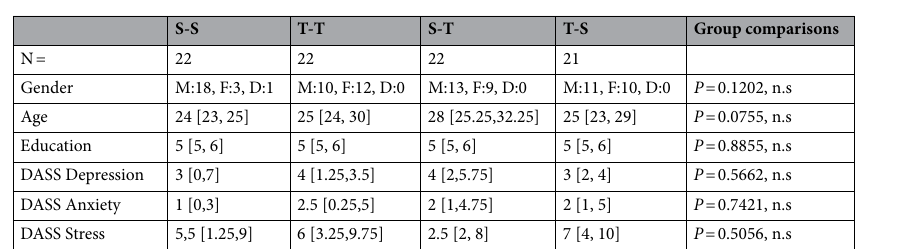
Figure 1. General experimental design and procedures. After the announcement of the presence or absence of distressing screams, the passive walkthrough 1 begun. The tracking shot started in the hallway and entered the rooms in ascending order (1–4). In each room the camera positioned itself at three locations in ascending order (marked by the circled numbers 1–3). Before the camera entered a new room, it returned to the starting point in the hallway. The red dot indicates the position of the person stimuli in the room. The person stimuli were either standing between the couch and the dresser or sitting on the couch. Apart from the person stimuli, all rooms were arranged identically. The rightmost picture depicts an exemplary room. After walkthrough 1 the participants were asked to rate their anxiety, stress and emotional arousal on a 9-point Likert scale and to estimate the length of the walkthrough. This process was repeated for walkthrough 2, which was similar to walkthrough 1, but differed in terms of the position of the person stimuli in the rooms and the route of the tracking shot. After the walkthroughs, the subjects engaged in a distraction task. After the distraction task, the subjects were asked to perform a memory recall and recognition test.